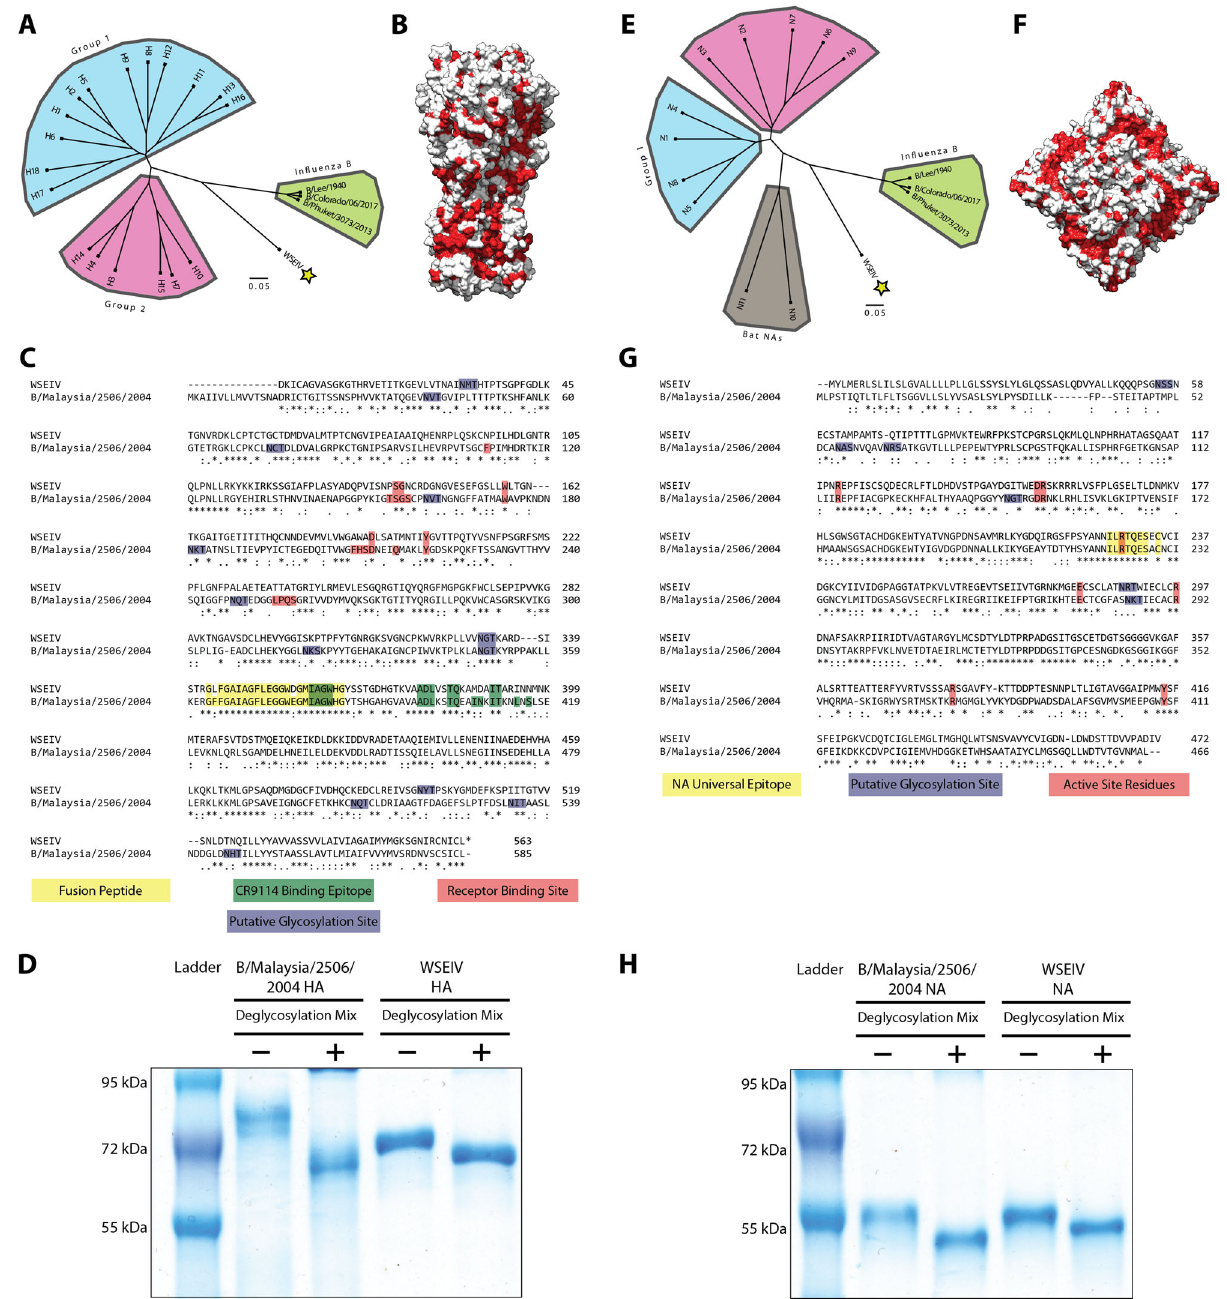
Fig. 1 Comparative sequence analysis of the WSEIV glycoproteins. Phylogenetic trees based on the amino acid sequences of the WSEIV glycoproteins and the representative in fl uenza A and B HAs ( A ) and NAs ( E ) obtained from GISAID are shown. The scale bar indicates a 5% difference in amino acid sequence. Amino acid conservation of the WSEIV HA ( B ) and WSEIV NA ( F ) relative to in fl uenza B virus HA and NA are represented by the residues highlighted in red. The structure and sequence of in fl uenza virus strain B/Brisbane/60/2008 were used as a template for comparison. Pairwise alignments of the WSEIV HA and NA are displayed against in fl uenza B/Malaysia/2506/2004 virus HA and NA, ( C ) and ( G ), respectively. Identical residues are indicated by asterisks. Functionally and antigenically relevant features have been annotated. Recombinantly expressed HAs ( D ) and NAs ( H ) of in fl uenza B/Malaysia/2506/2004 virus and WSEIV were visualized on an SDS – PAGE gel in deglycosylated and non-deglycosylated conditions. A representative of two independent assays is shown. Structures are based on PDB# 4FQM 50 for HA and PDB# 4CPL 51 for